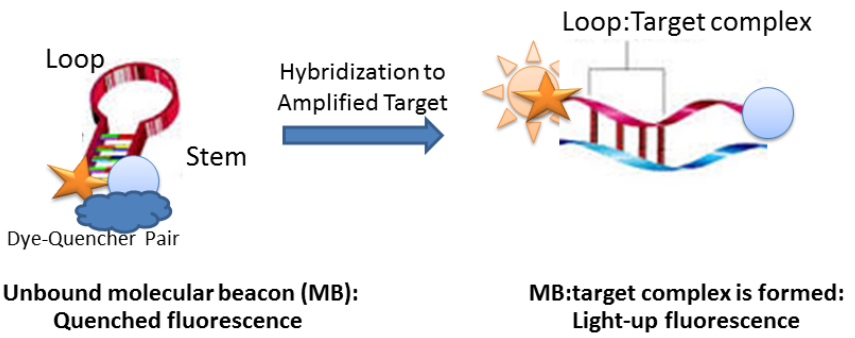
Figure 3. Detection of amplified DNA by molecular beacon